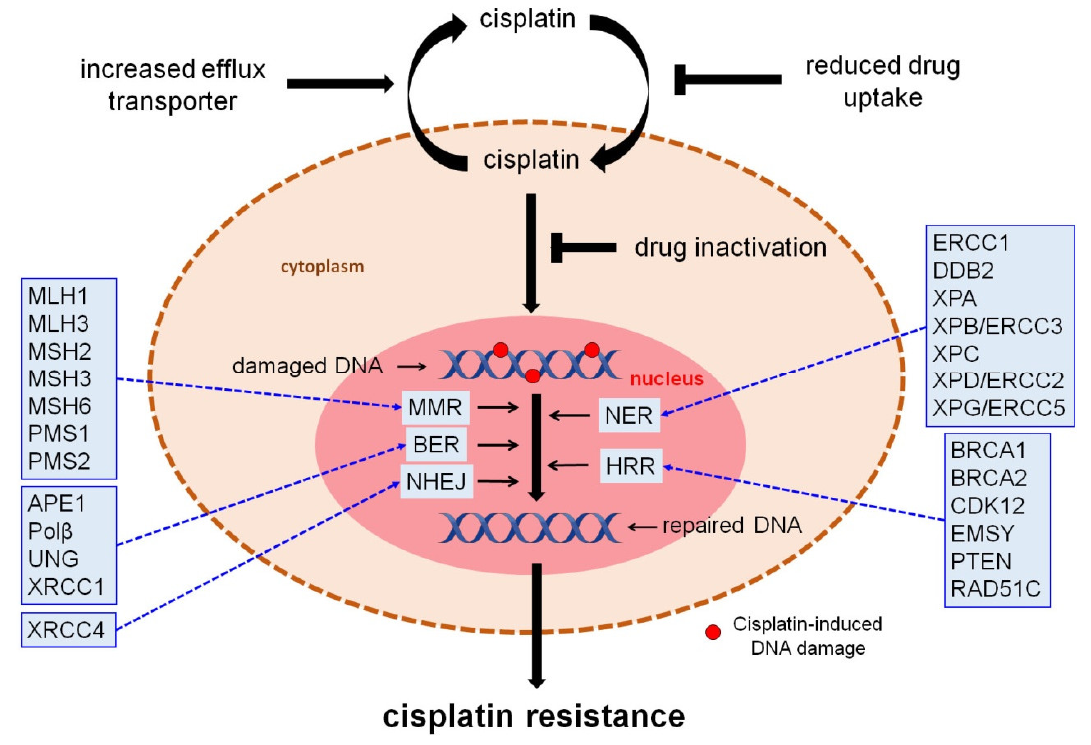
Figure 2. Molecular mechanisms of cisplatin resistance. Cells block cisplatin from damaging DNA by decreasing drug uptake, increasing drug efflux, and augmenting drug detoxification by binding to glutathione or metalloproteins. Following DNA damage induction, cells remove the lesions using critical DNA repair mechanisms. Molecular components that were found deregulated in OC, including MLH1, MLH3, MSH2, MSH3, MSH6, PMS1, PMS2 (MMR), APE1, Pol β , UNG, XRCC1 (BER), XRCC4 (NHEJ), ERCC1, DDB2, XPA, XPB/ERCC3, XPC, XPD/ERCC2, XPG/ERCC5 (NER) and BRCA1, BRCA2, CDK12, EMSY, PTEN, and RAD51C (HRR) can be possibly exploited as novel